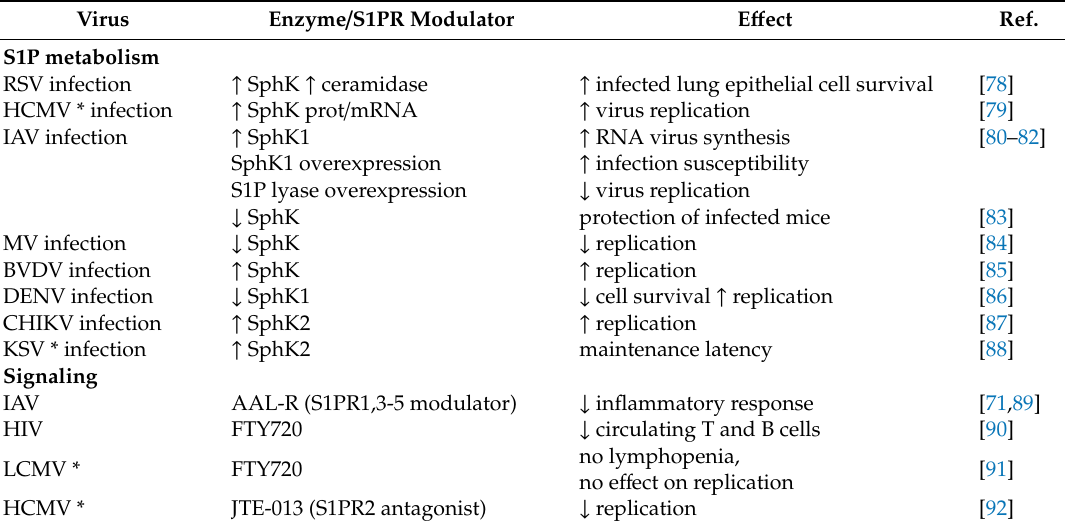
Table 1. Involvement of S1P in virus infection. The table illustrates the e ff ect of viral infection on SphK activity / expressionas wellas thee ff ects onthe virus infectionresponse dueto modulations / modifications of the expression / activity of enzymes involved in S1P metabolism or modulators of S1PR. The table reports data from RNA viruses (positive-sense, single-stranded RNA) as SARS-CoV2 (BVDV, DENV, CHIKV, LCMV and HIV), from RNA virus (negative-sense, single-stranded RNA) as IAV and measles virus, and from DNA virus (*). BVDV: bovine viral diarrhea virus; CHIKV Chichungunya virus, DENV: dengue virus type 2; HCMV: human cytomegalovirus; HIV: human immunodeficiency virus; IAV: influenza A virus (H1N1); KSV: Kaposi’s sarcoma-associated herpes virus; LCMV lymphocytic choriomeningitis virus; RSV: respiratory syncytial